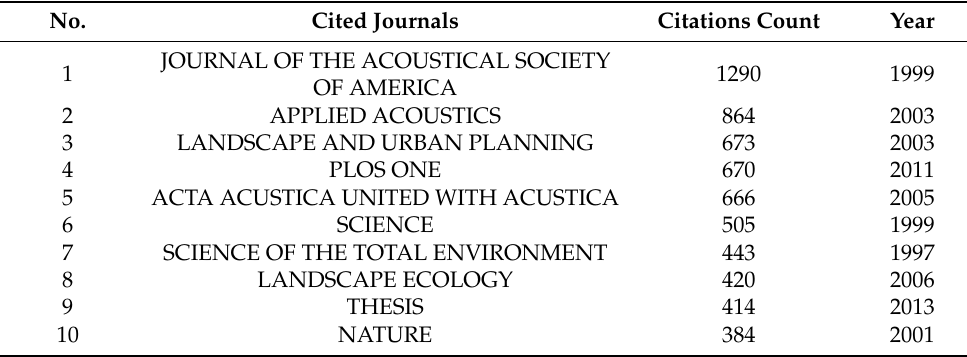
Table 2. Top 10 most-cited journals in the field of soundscape.